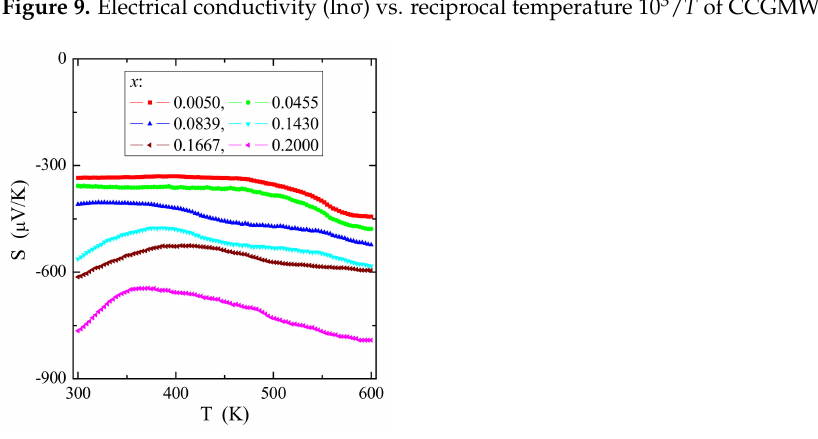
Figure 10. Thermoelectric power S vs. temperature T of CCGMWO solid